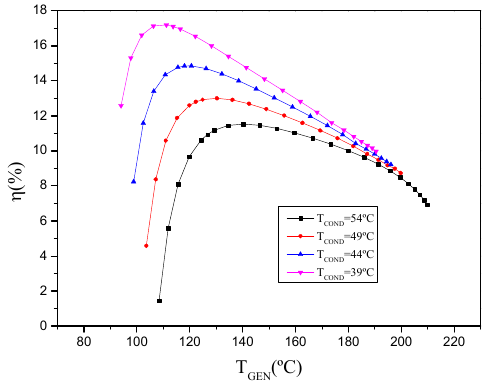
ffi ciency of the basic cycle versus T